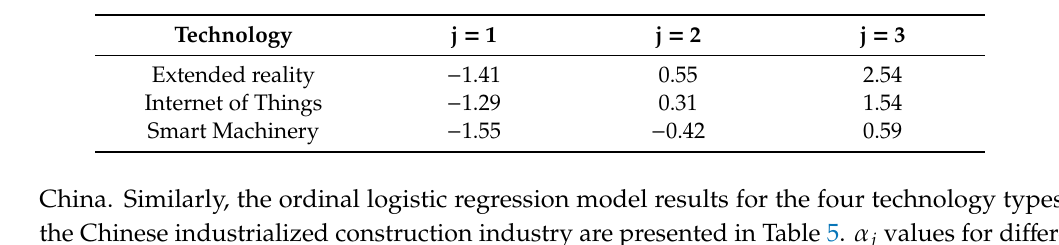
Table 4. 𝛼 𝑗 value of different technology types for the United States.